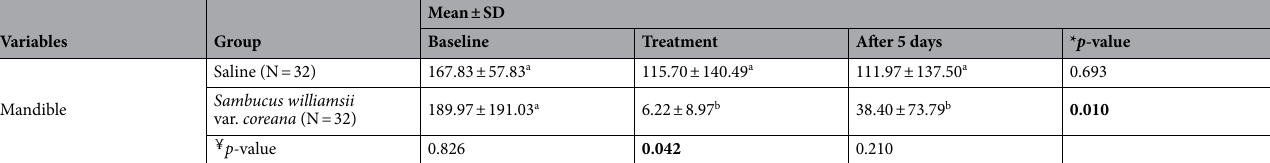
Table 5. Gram-negative bacterial measurements in subgingival plaque (7 types). ￥ p -values are determined by independent t-test, * p -values are determined by one-way ANOVA and different letters (a and b) by the presented statistically significant result of the post hoc Tukey HSD ( P < 0.05). Values are means ± standard deviations. Significant